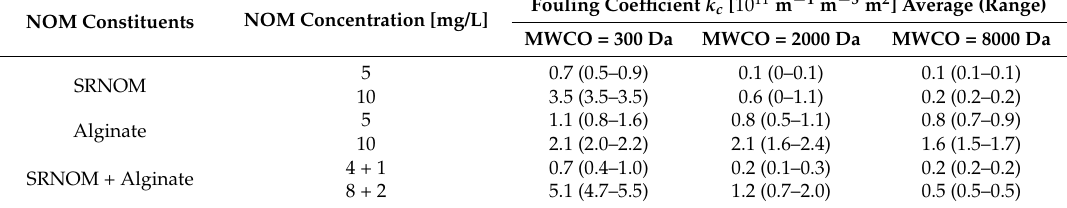
Fouling coefficient k c for different filtration tests (ranges correspond to observed minimum/maximum